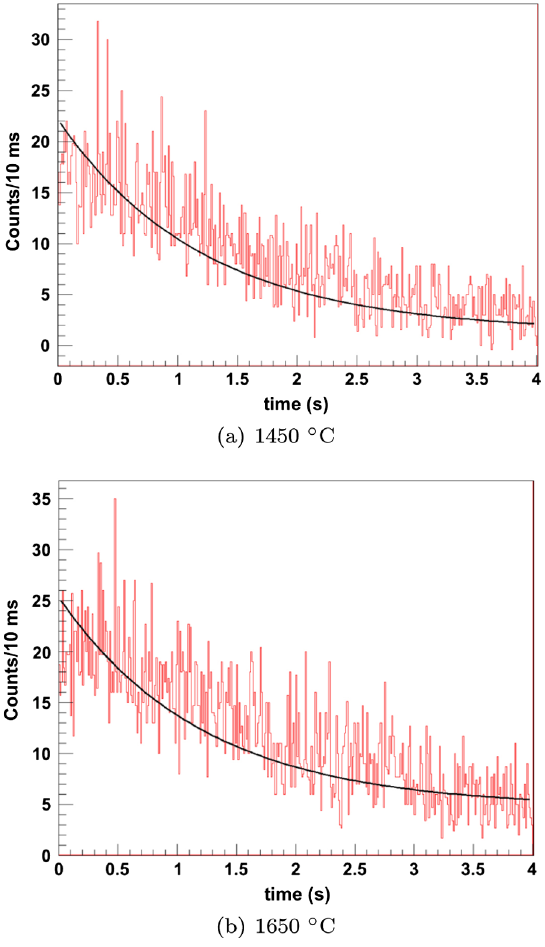
FIG. 14. Decay of 8 Li (setup with the collection device) at 1450 °C and 1650 °C. χ 2 =n ð 1450 °C Þ ¼ 574 . 7 = 397 ; χ 2 =n ð 1650 °C Þ ¼ 494 . 4 = 398 .